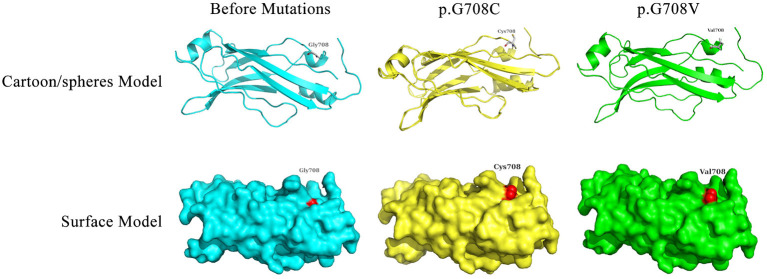
Display of the predicted protein structures before/after mutations of RPGRIP1L at position 708. The red color indicated the amino acid mutation site. Gly, glycine; Cys, cysteine; Val, valine.